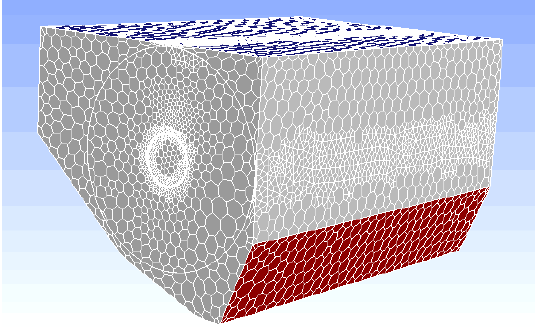
Figure 6. Polyhedral mesh after optimization.